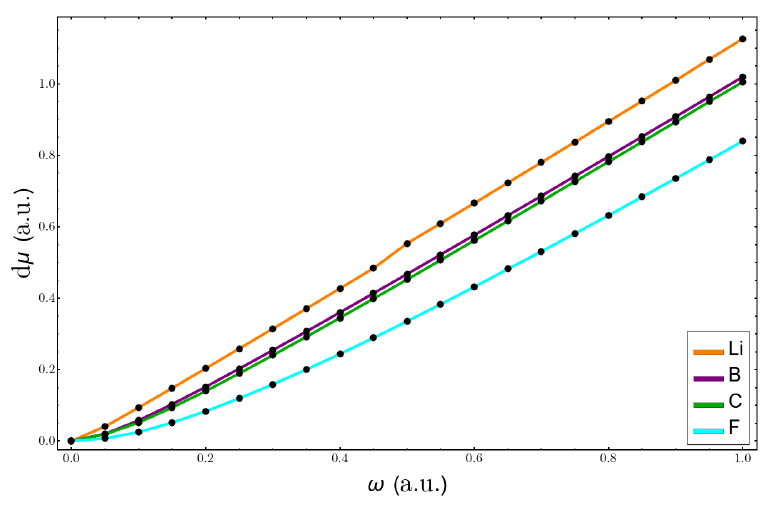
Figure 8. Change in electronegativity with confinement, using Equation (10), for Li, B, C, and F atoms.